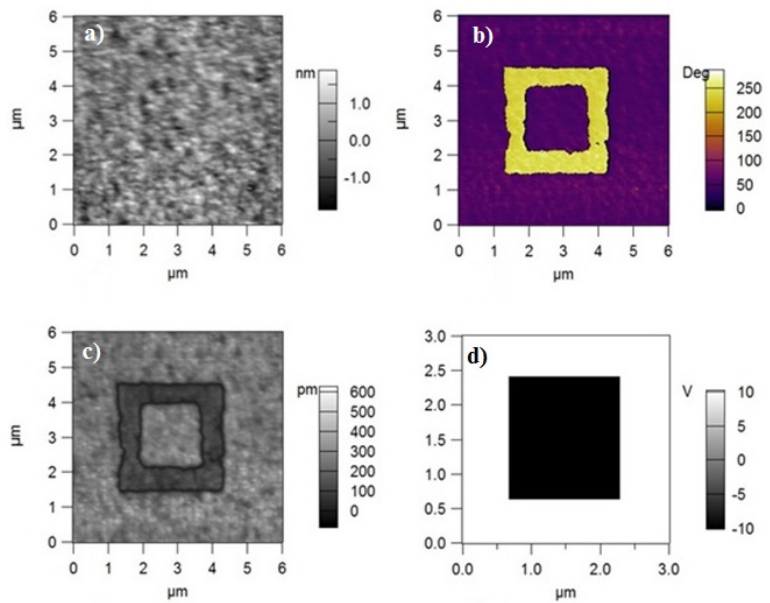
Figure 3. ( a ) The topography of the BFO thin film; ( b ) the phase obtained during a PFM scan after poling; ( c ) the amplitude obtained during a PFM scan after poling; ( d ) the poling